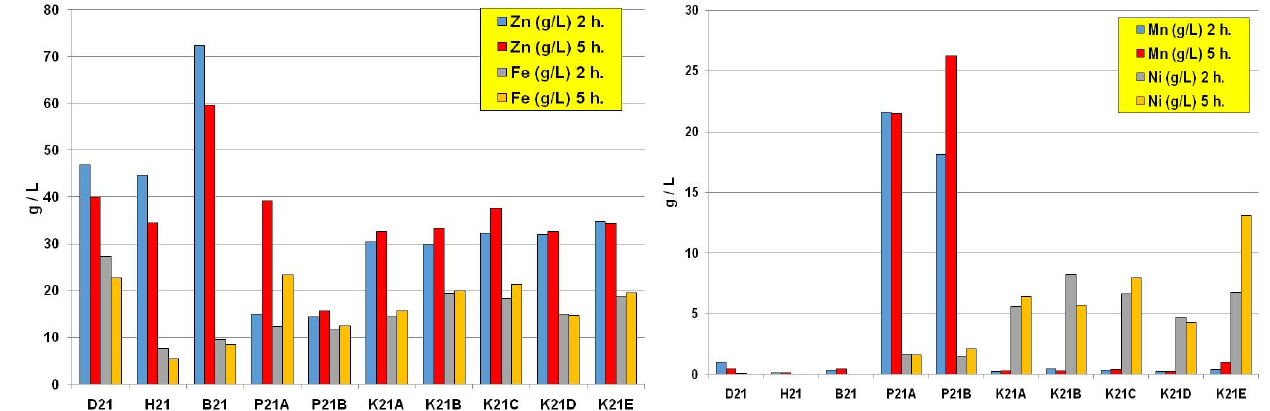
Figure 5. AAS analyses of leaches after sludge leaching in 20% H 2 SO 4 after 2 and 5 h.